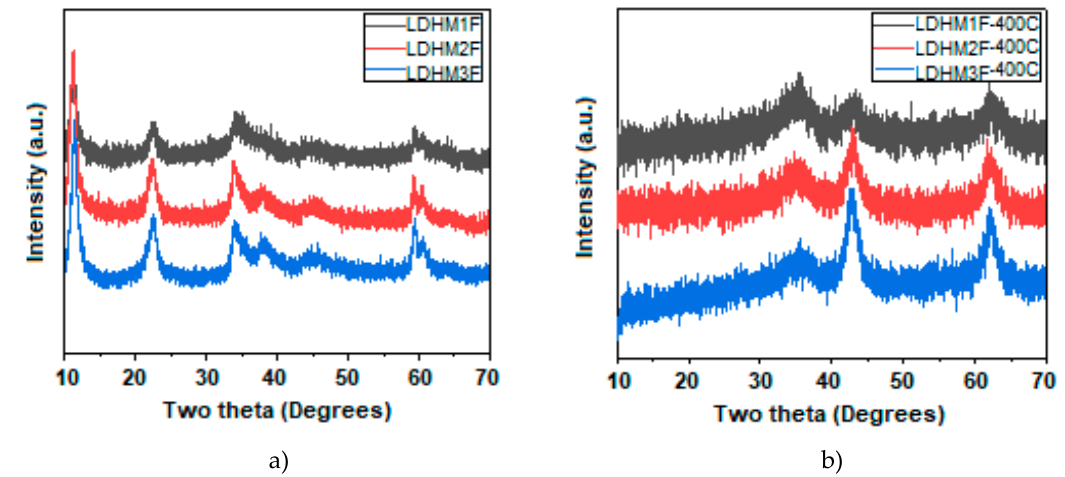
Figure 1. X-ray diffraction patterns of Mg/Fe layered double hydroxides. a ) Fresh and b ) thermally Figure 1. X-ray di ff raction patterns of Mg / Fe layered double hydroxides. ( a ) Fresh and ( b ) thermally active at 400 °C. active at 400 ◦